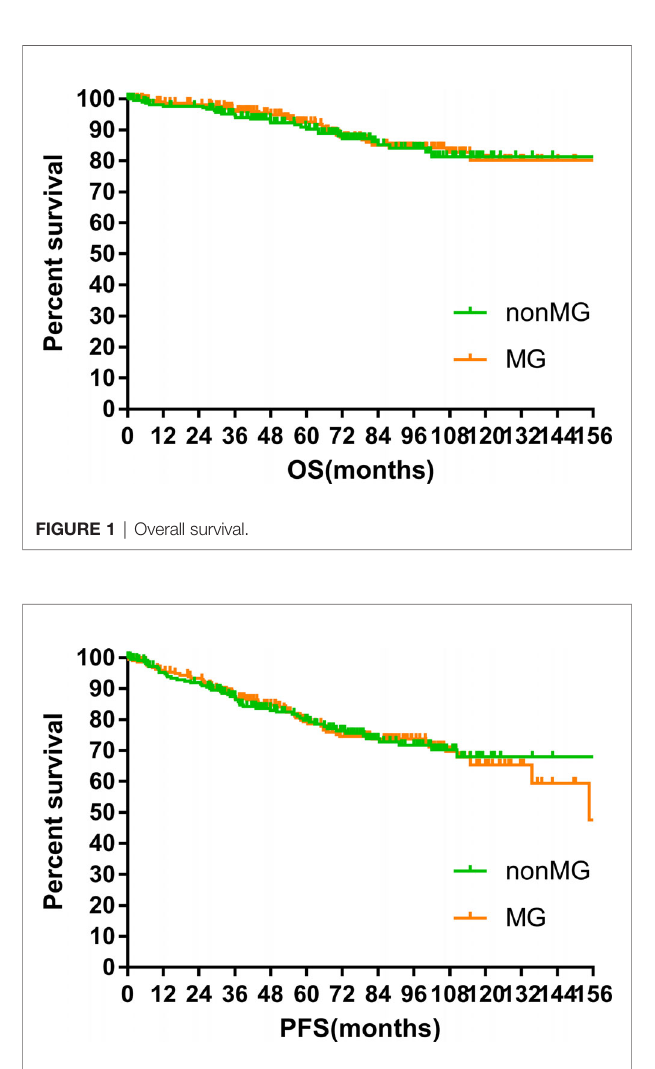
FIGURE 5 | Cancer speci fi c